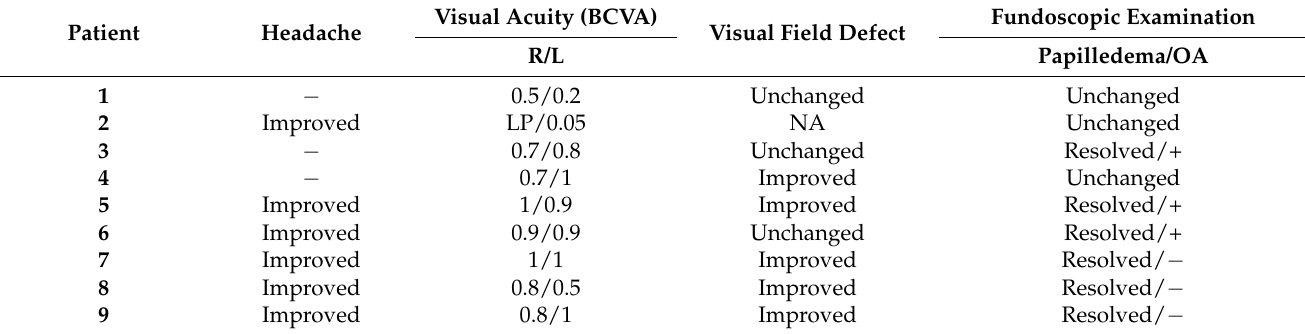
Table 2. Postoperative clinical features of patients. BCVA: Best Corrected Visual